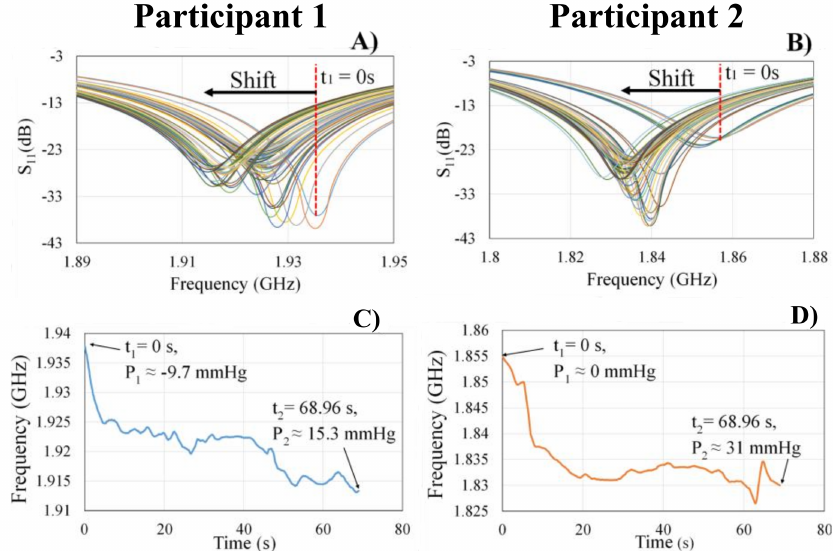
Figure 8. The sensor’s signal response corresponding with a cephalad bio-fluid shift was seen as shifts in the sensor’s principal resonant frequency in ( A ) participant 1 and in ( B ) participant 2. Each line color represents the sensor signal response at different times during the bio-fluid shift. The resonant frequency shift during an induced bio-fluid shift over time for ( C ) participant 1 and ( D ) participant